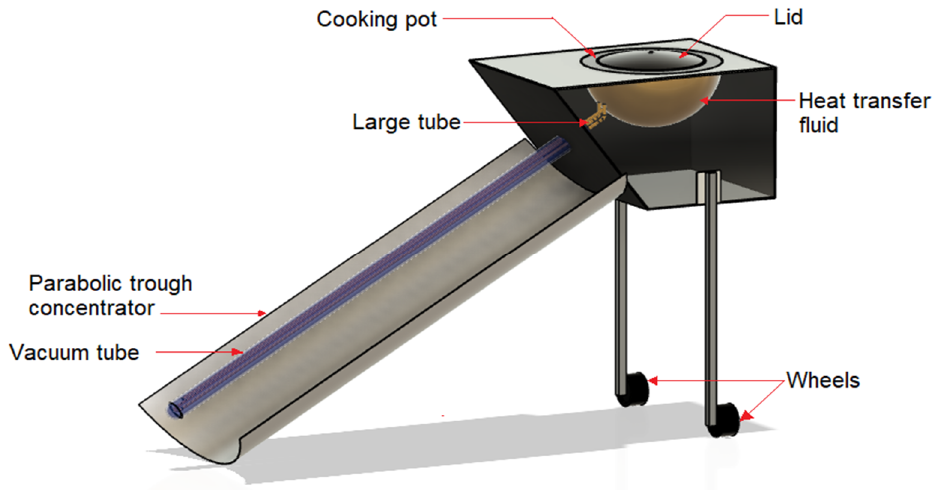
Figure 6. Solar Parabolic trough concentrating cooker. Reprinted/adapted with permission from (2020) El Moussaoui et al. [95].